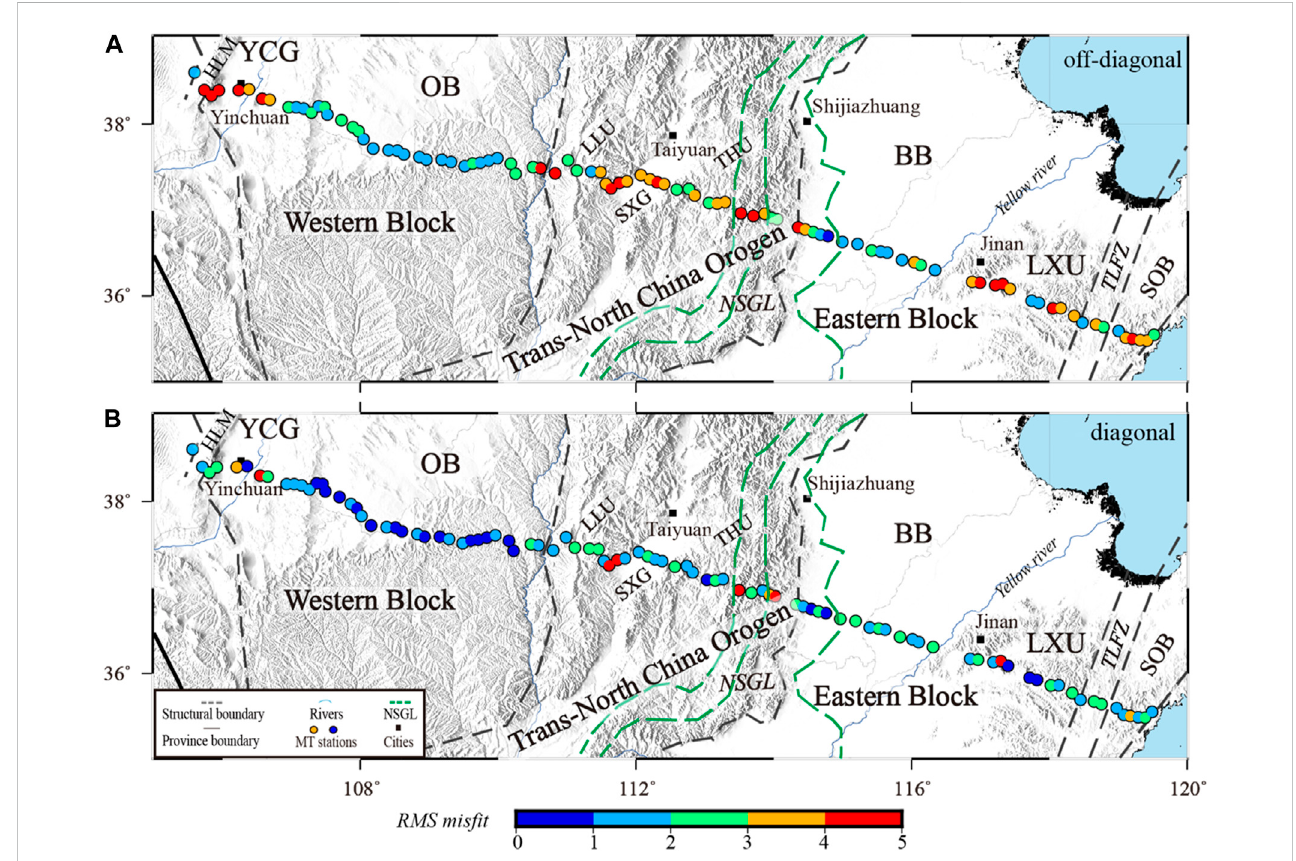
FIGURE 6 TheRMSmis fi tsof3Dinversionofoff-diagonalanddiagonalcomponentsofeachstation. (A) off-diagonal,and (B) diagonal.HLM:HelanMountain,YCG: Yinchuan Graben, OB: Ordos Block, LLU: Lüliang Uplift, SXG: Shanxi Graben, THU: Taihang Uplift, BB: Bohaiwan Basin, LXU: Luxi Uplift, SOB: Sulu Orogenic Belt, TLFZ: Tan-Lu Fault Zone, and NSGL: North-South Gravity lineament after (Deng et al.,